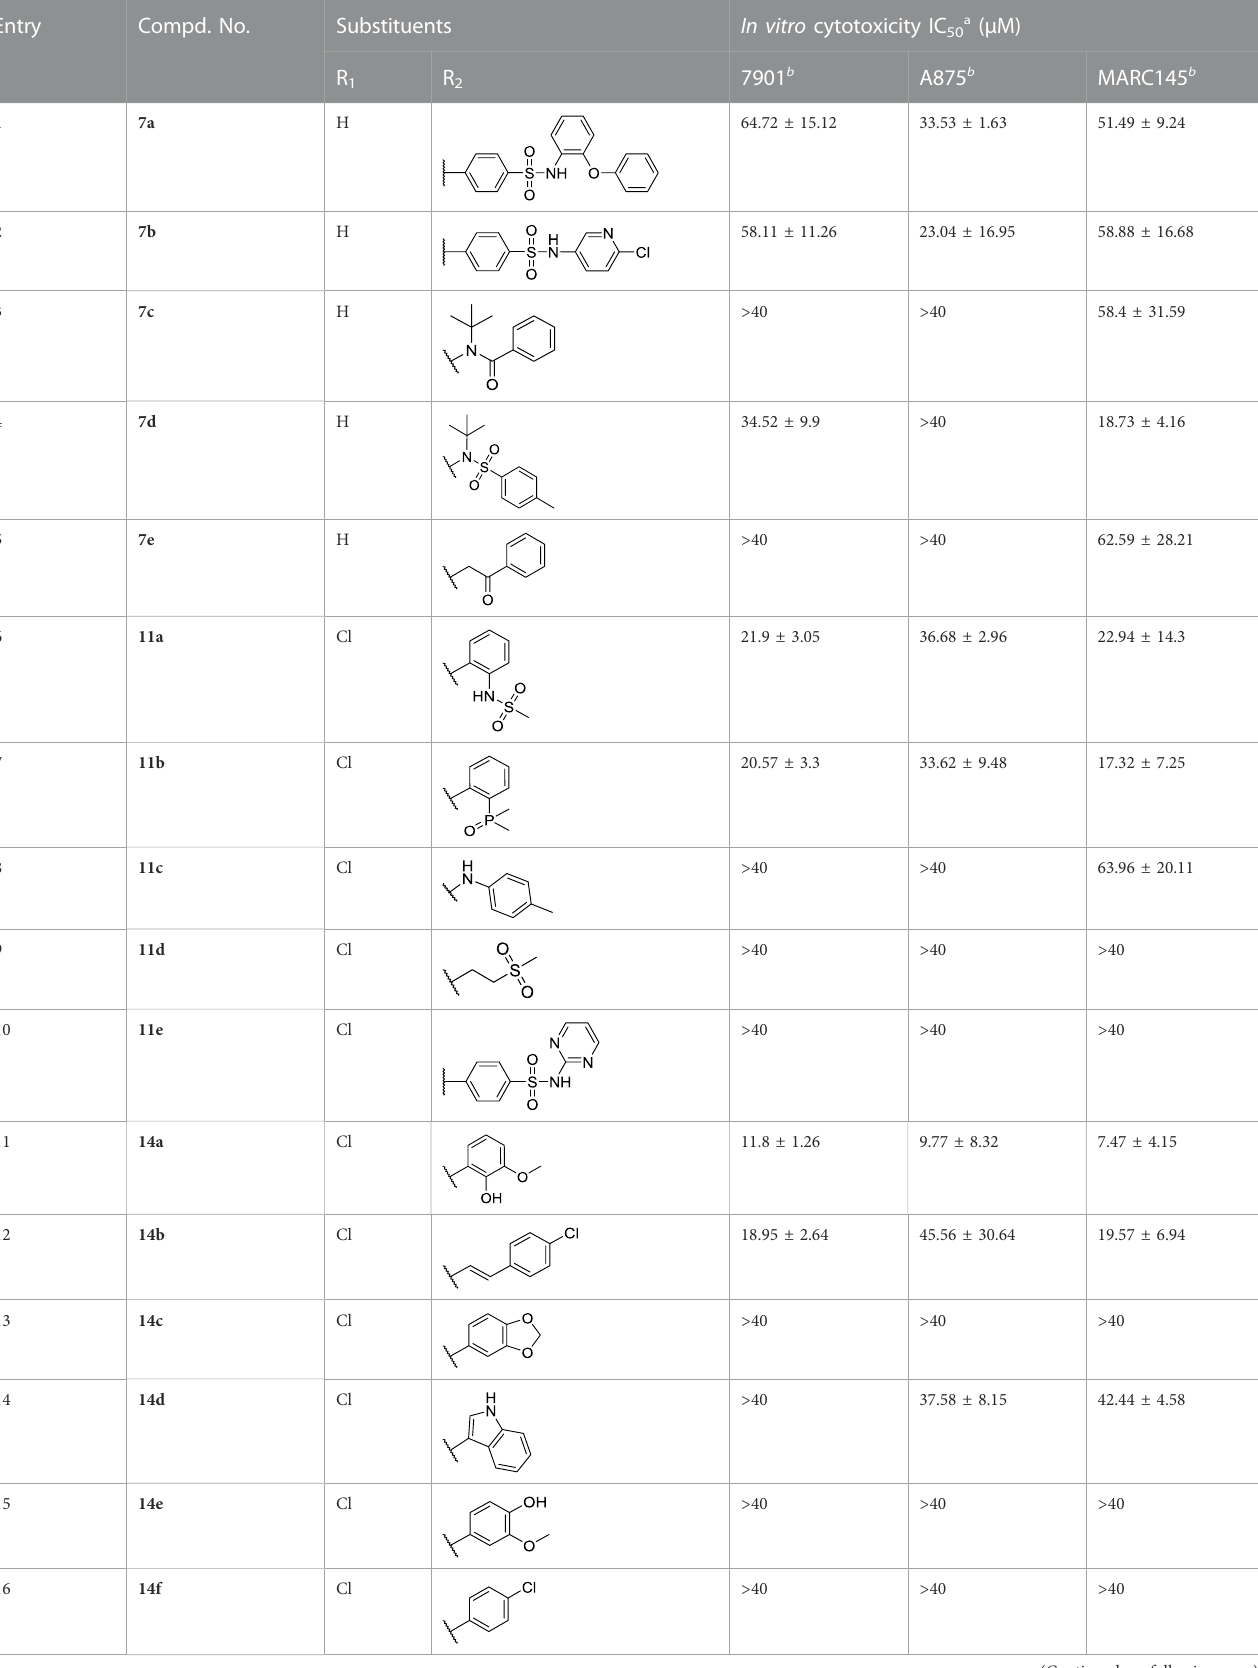
TABLE 1 In vitro cytotoxic activities of target compounds against tested cell lines. Entry Compd.